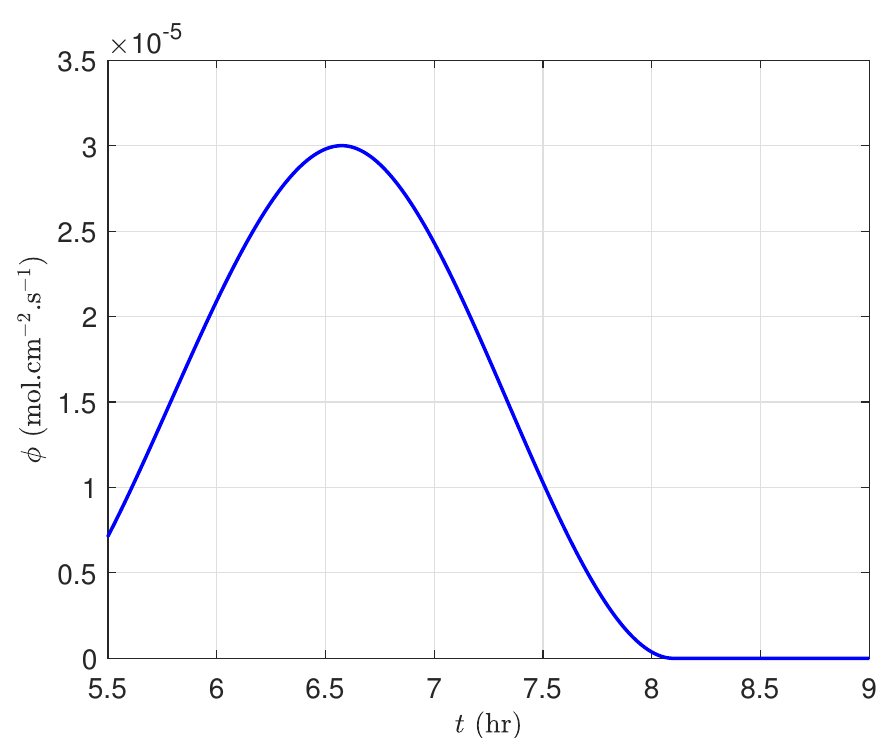
Figure 5. Steam flow rate generated by water influx from nearby aquifers with